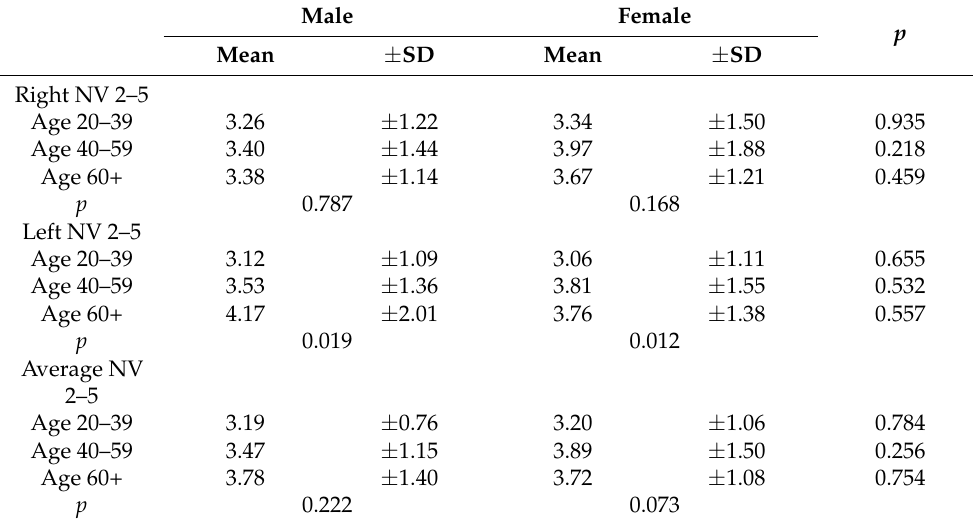
Table 6. Nasal volume (cm 3 ) of the nasal cavity between 2.0 and 5.0 cm from the tip of the nose- piece (NV 2 – 5).